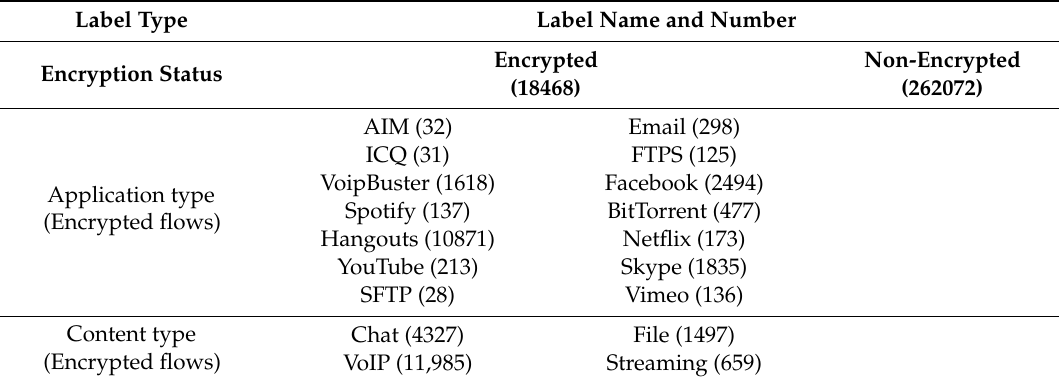
Table 2. Flow labels and number of flows used in the experiments.